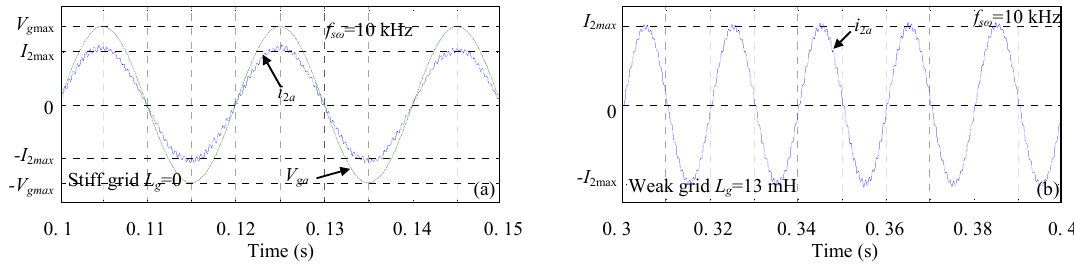
Figure 12. Simulation results during steady state operation ( a ) grid voltage V ga and current i 2 a waveforms ( b ) grid current i 2 a response for L g = 13 mH.